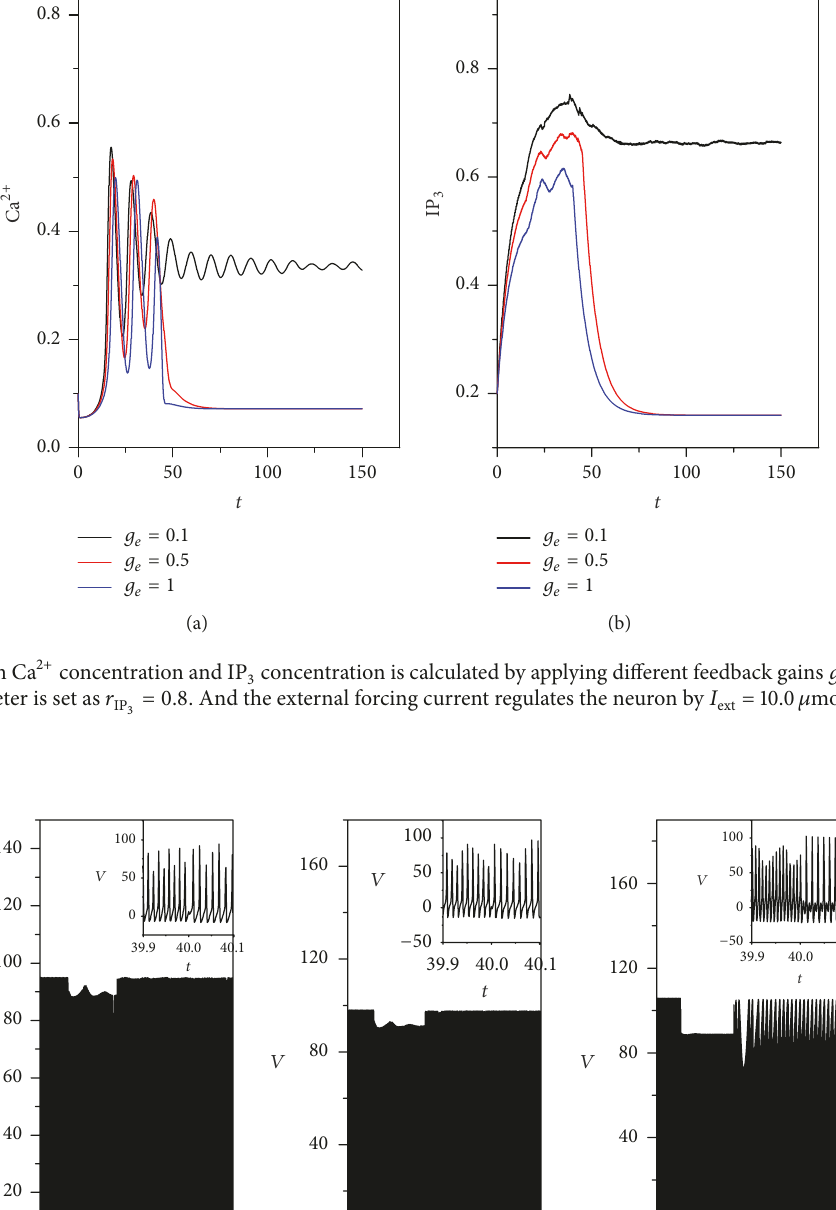
Figure 9: Sampled time series for membrane potential of neuron coupled by astrocypte when autapse driving is considered at 𝜏 = 2 , for = 0.8 , and inserted figures are enlarged ones. And the external (a) 𝑔 𝑒 = −0.1 , (b) 𝑔 𝑒 = −0.5 , and (c) 𝑔 𝑒 = −1.0 . The parameter is set as 𝑟 IP 3 forcing current regulates the neuron by 𝐼 ext = 10.0 𝜇 mol/L ⋅ cm 2 at 𝑡 < 40 s. The inserted figure is enlarged to show the sampled time series for membrane potential from 𝑡 = 39.8 to 40.2